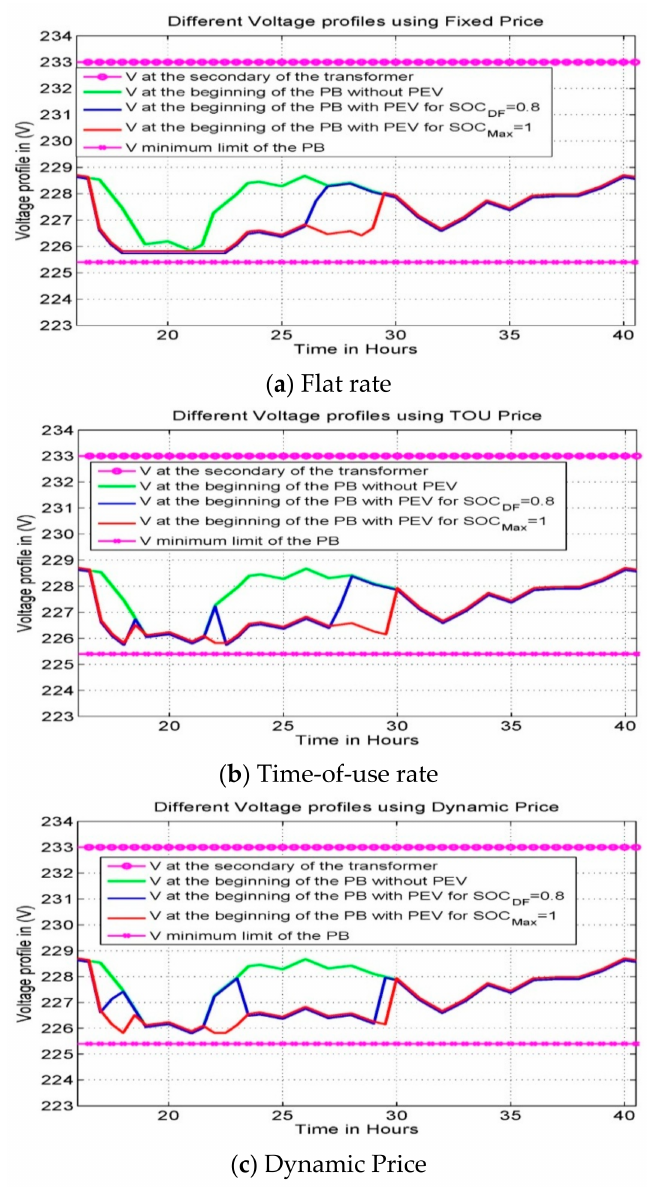
Figure 5. Voltage profiles for SOC Max = 1 and SOC D = 0.8, for ( a ) Flat rate, ( b ) TOU, ( c ) Dynamic price. Tables 1–3 represent the power quality under three different pricing mechanisms.